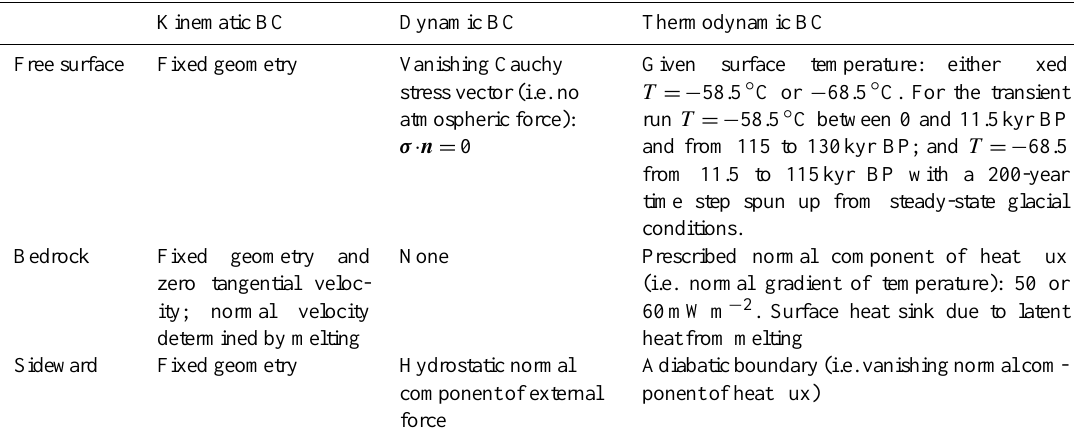
Table 1. Boundary conditions for the simulations. Kinematic BC Dynamic BC Thermodynamic BC Given surface temperature: either fixed Free surface Fixed geometry Vanishing Cauchy T =− 58.5 ◦ C or − 68.5 ◦ C. For the transient stress vector (i.e. no run T =− 58.5 ◦ C between 0 and 11.5kyr BP atmospheric force): σ · n = 0 and from 115 to 130kyr BP; and T =− 68.5 from 11.5 to 115kyr BP with a 200-year time step spun up from steady-state glacial conditions. Prescribed normal component of heat flux (i.e. normal gradient of temperature): 50